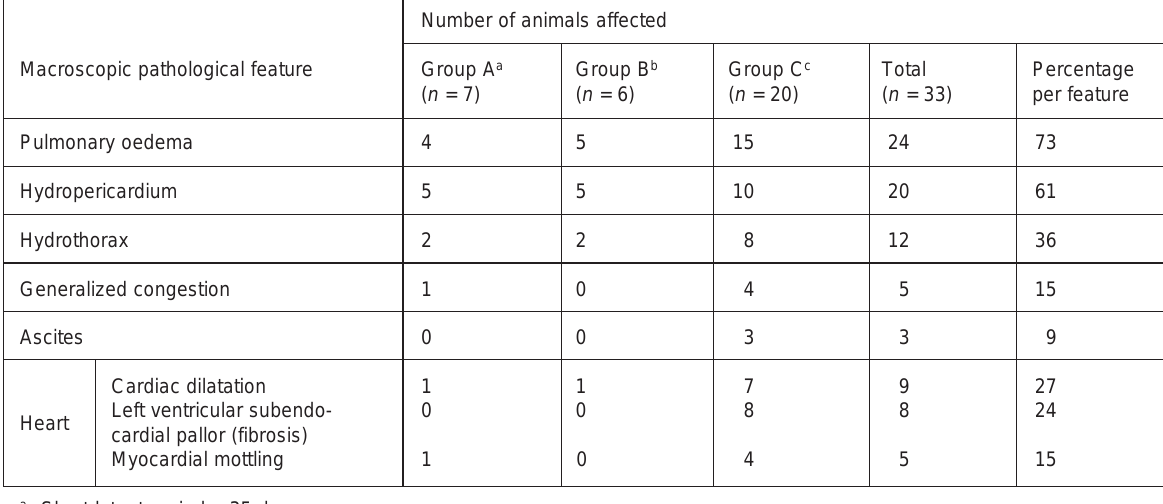
TABLE 3 Macroscopic pathological features in 33 sheep in Series 1 Number of animals